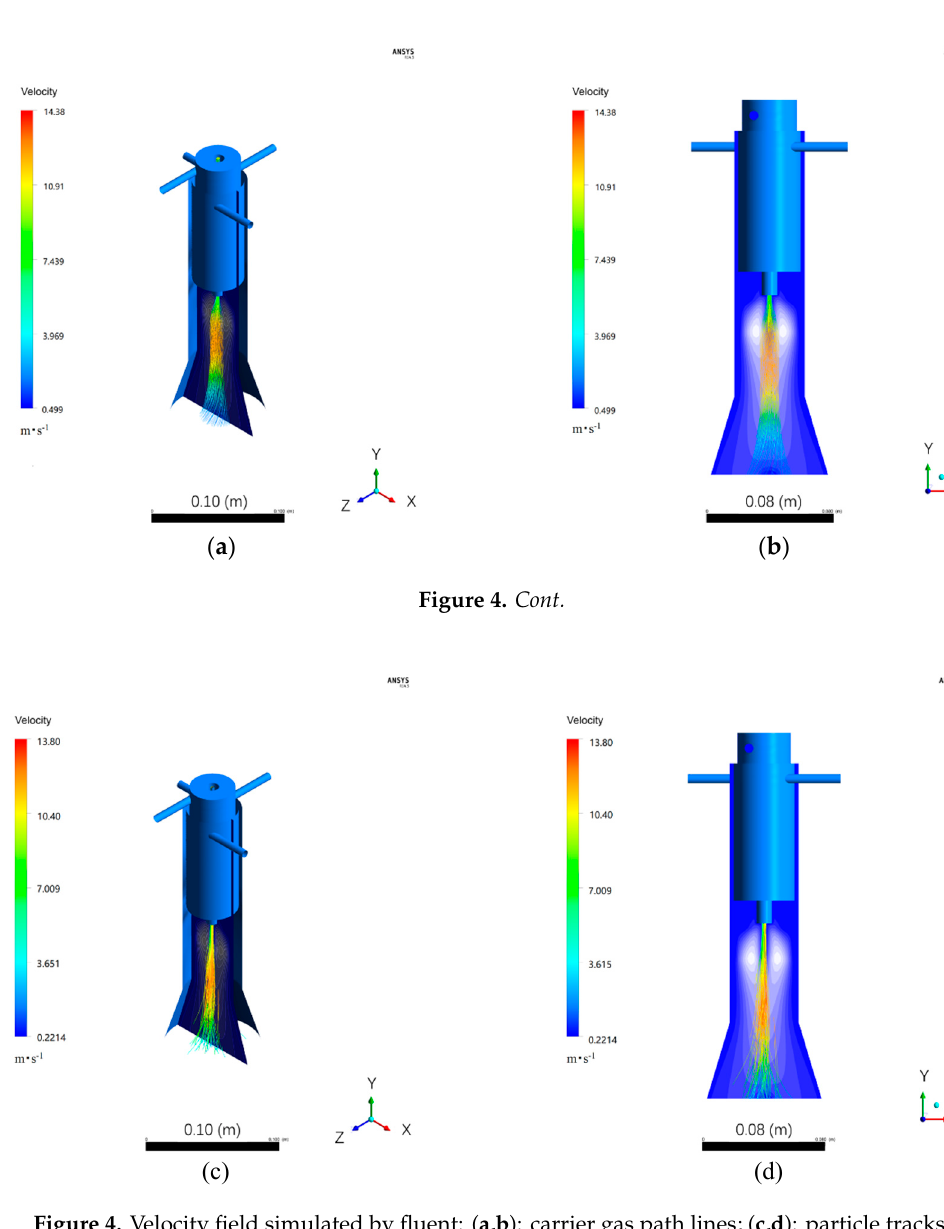
Figure 4. Velocity field simulated by fluent: ( a,b ): carrier gas path lines; ( c,d ): particle tracks.